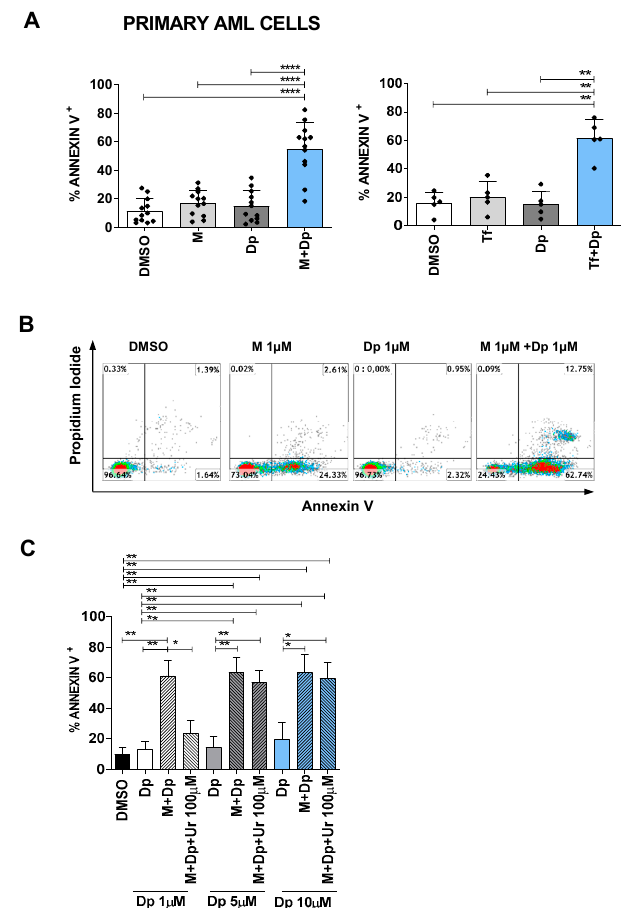
Figure 9. The combination of dipyridamole and DHODH inhibitors is effective against primary AML cells. ( A ) Apoptosis induced by MEDS433 (left panel, n = 12) or teriflunomide 100 µ M (right panel, n = 5), alone and in combination with dipyridamole, on AML primary cells. ( B ) Flow cytometry plots of a representative sample of primary AML cells treated with MEDS433, dipyridamole and their combination (patient 3 of Table S2). ( C ) Apoptotic rate induced by MEDS433 alone and in combina- tion with increasing dipyridamole concentrations, with or without uridine at hyperphysiological concentrations (100 µ M), on primary AML samples ( n = 4). In all the experiments, MEDS433 was utilized at 1 µ M and apoptosis was evaluated after 3 days of treatment; unless otherwise specified, dipyridamole was utilized at 1 µ M. DMSO: dimethyl sulfoxide. M: MEDS433. Dp: dipyridamole.